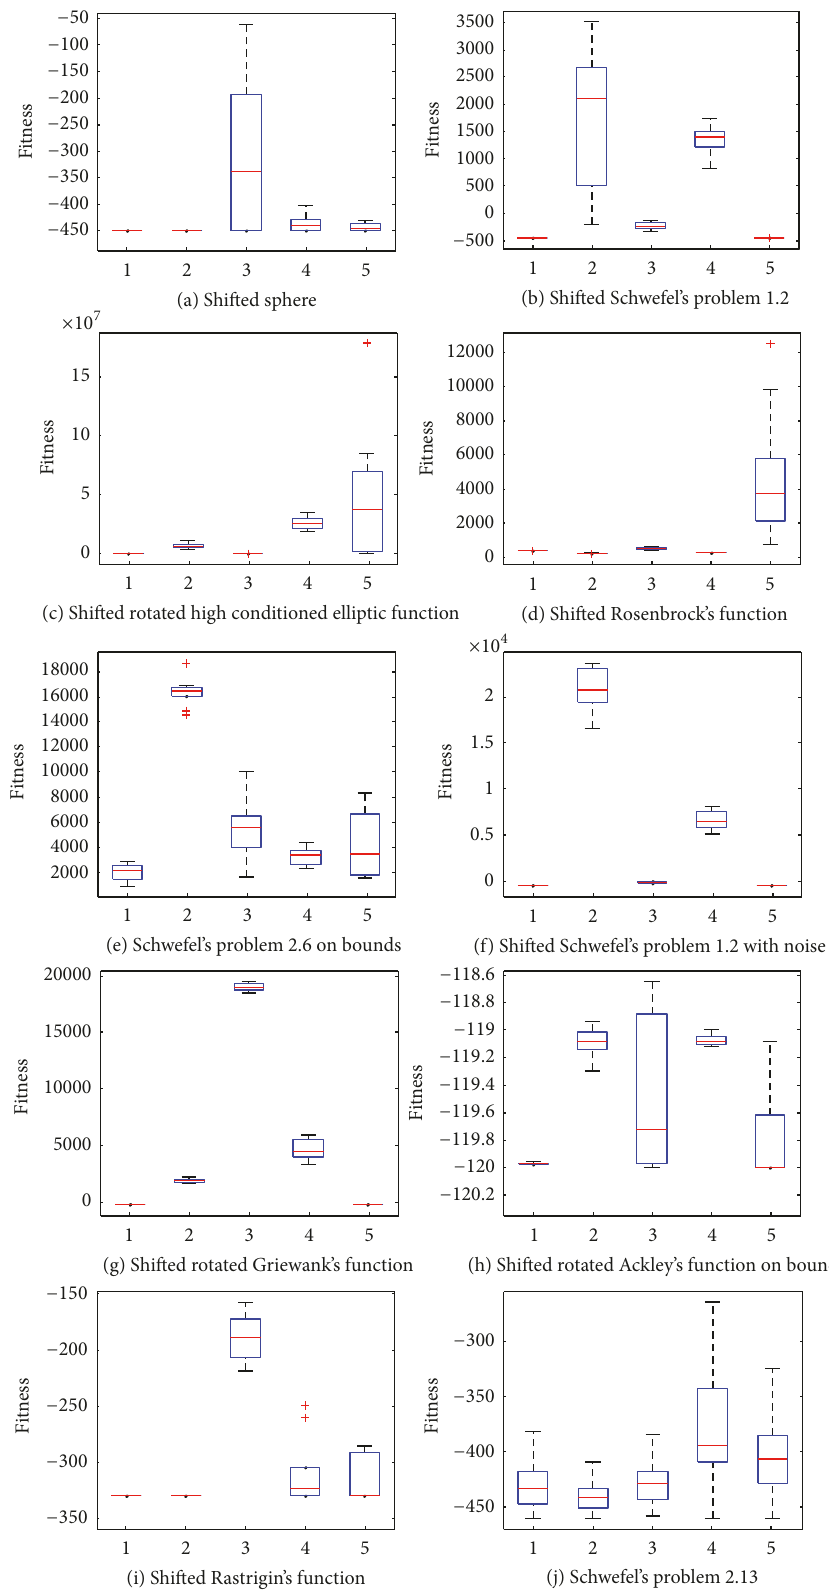
Figure 3: Box plots of results obtained by all algorithms. Here, 1 to 5 in the horizontal axis are indices of MCPSO-PSH, NrGA, CMA-ES, PSO, and DE, respectively (the box has lines at the lower quartile, median, and upper quartile values. The whiskers extend to the most extreme data points not considered outliers. Outliers (denoted by +) are data with values beyond 100 units of interquartile